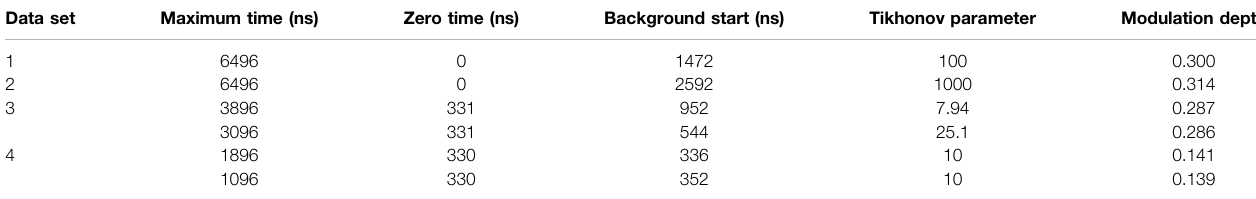
TABLE 1 | DeerAnalysis parameters. Data set